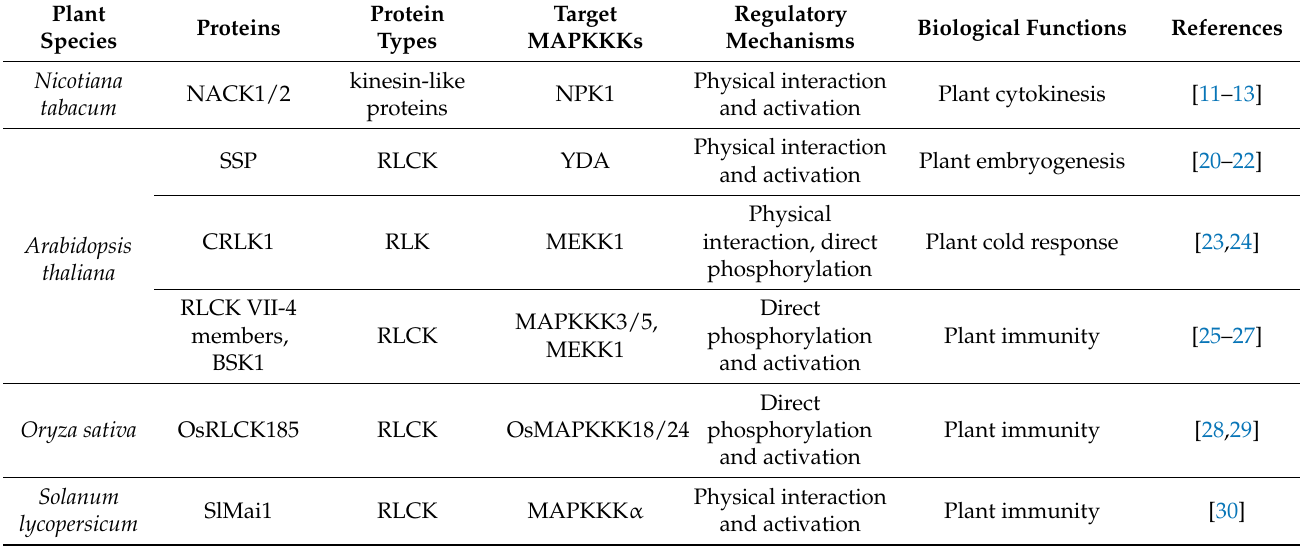
Table 1. Representative activation of MAPKKKs by various proteins in